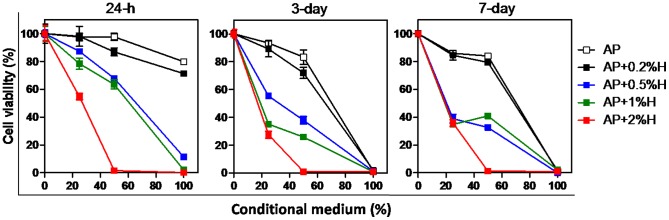
Cytotoxicity of Apexit Plus containing 0.2%–2% hinokitiol were increased by time and dose.(A) MTT test analysis of the cytotoxicity of extraction of the sealers (AP and AP+0.2%–2%H) conditional medium treated to MG-63 for 24 h (left panel), 3-days (middle panel), and 7-days (right panel). Two folds serial dilution of these conditional media (0%, 25%, 50%, and 100%) were tested. Three independent experiments were performed in triplicate.